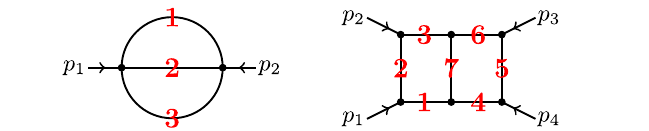
Fig. 2 Examples of Maximal loop topologies at two loops, the sunrise (left) and the double-box (right) topologies. The red label corresponds to the propagator number